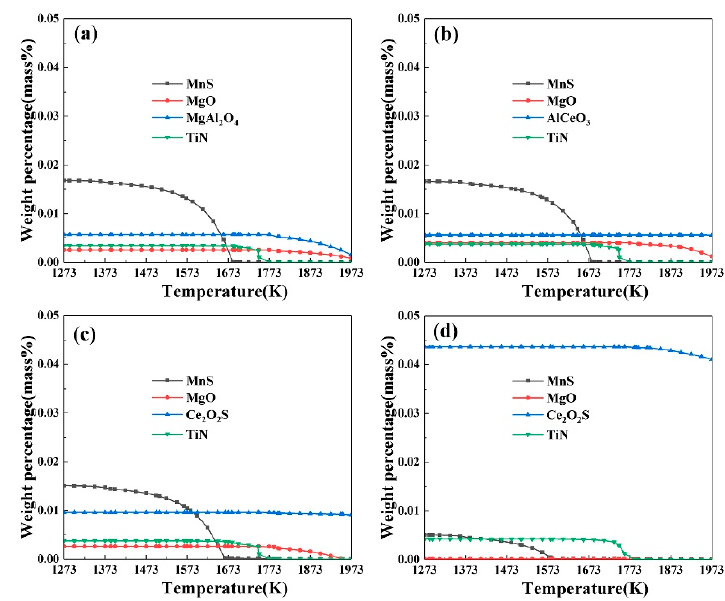
Figure 3. Thermodynamic calculation results of the as-cast steels. ( a ) #1 (Ce-free); ( b ) #2 (0.014% Ce); ( c ) #3 (0.024% Ce); ( d ) #4 (0.037% Ce).